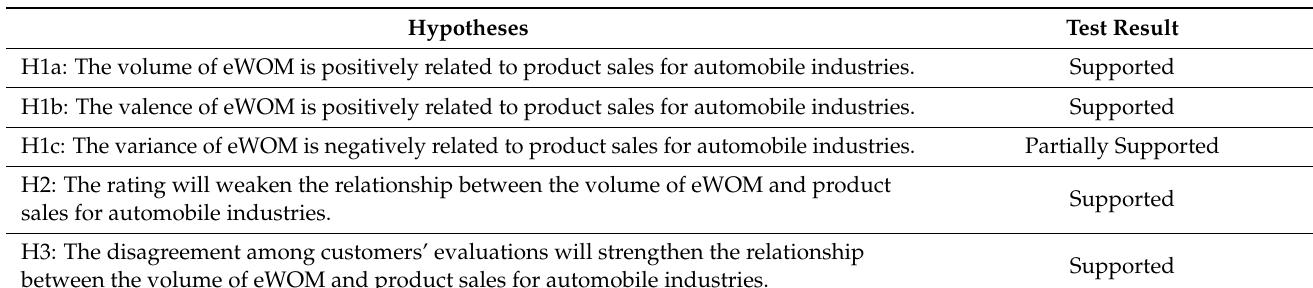
Table 7. Hypotheses test